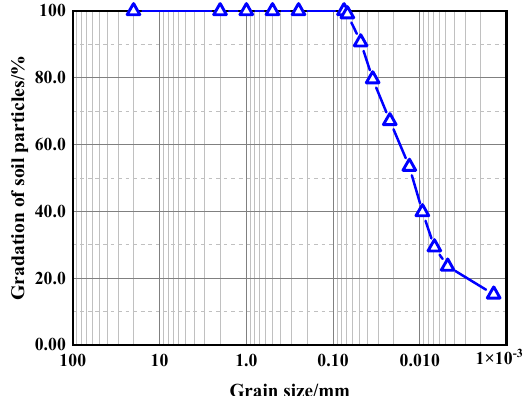
Figure 3. Grain size distribution curve.